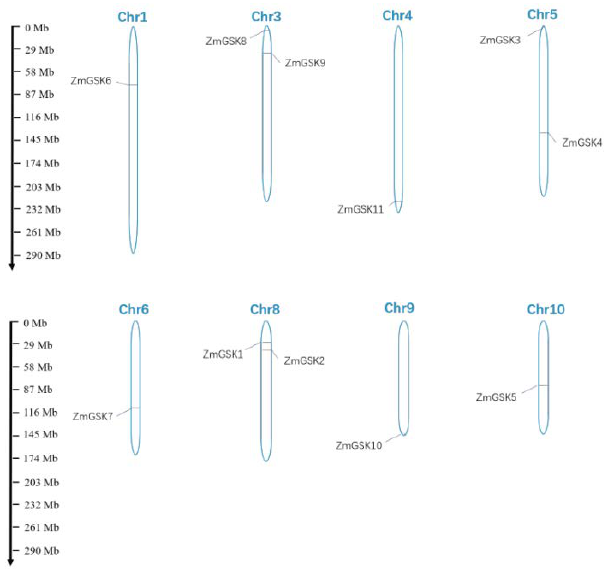
Figure 2. Distribution of ZmGSK genes on maize chromosomes. The scale represents megabases (Mb).